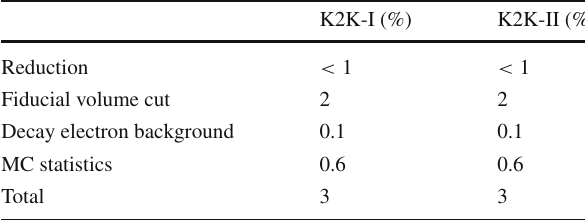
Table 8 Systematic errors for N